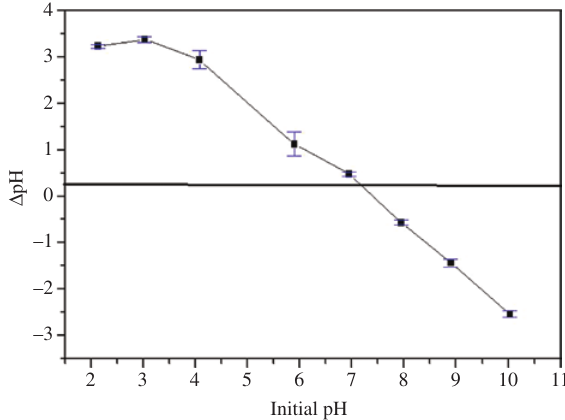
Figure 5: Relationship between ∆pH and initial pH value of water containing 0.1 g HAp.